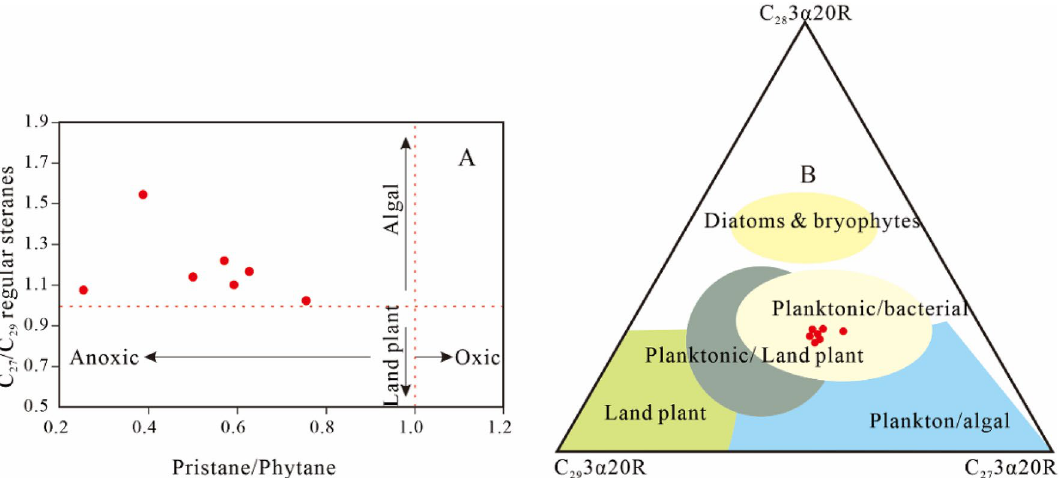
Figure 4. A: Pristane/Phytane versus C27/C29 regular steranes plot. B:C 27 , C 28 , C 29 ααα-20R regular sterane triangular diagram indicating the compositions, organic matter input, and depositional environment for the analyzed Xiahuapidianzi Formation extracts (modified after Makeen, Y. F. et al . 28